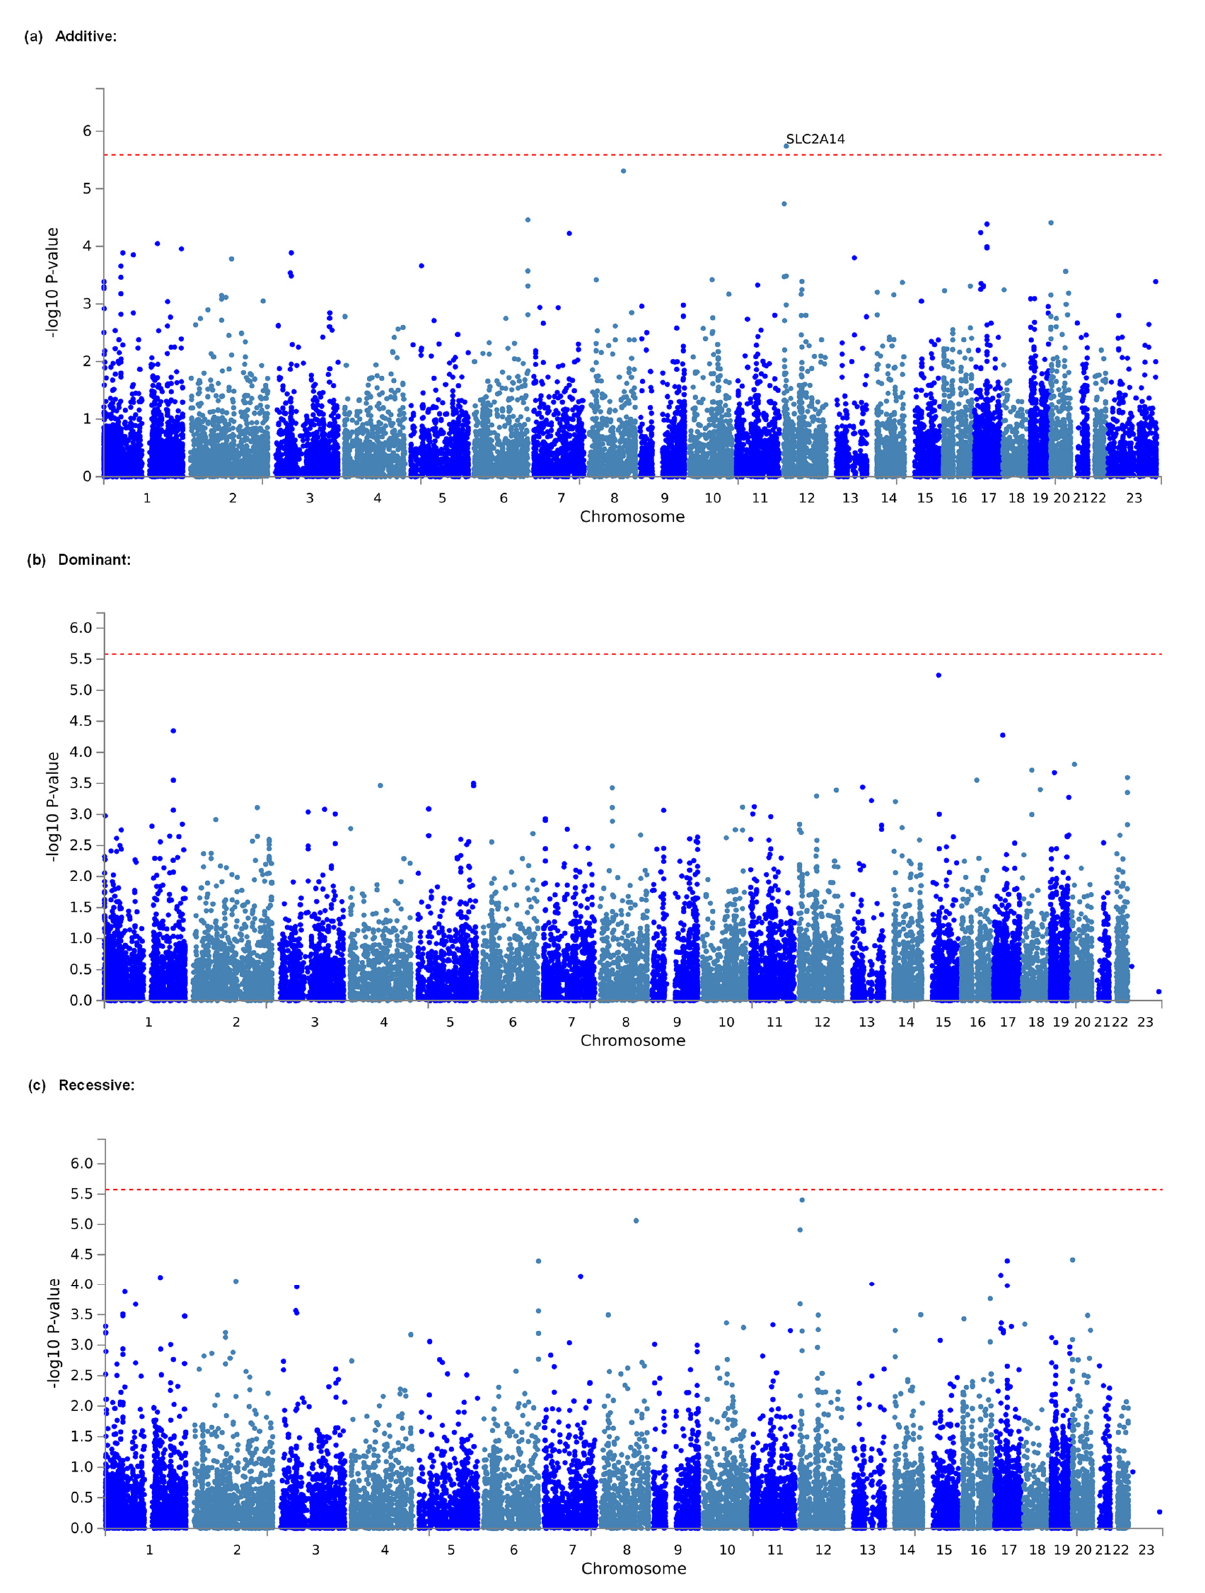
Figure 2. Manhattan plot of results of gene-based analysis. ( a ) Analytical plot in the additive model. ( b ) Analytical plot in the dominant model. ( c ) Analytical plot in the recessive model. The dashed red line shows the significant association threshold.